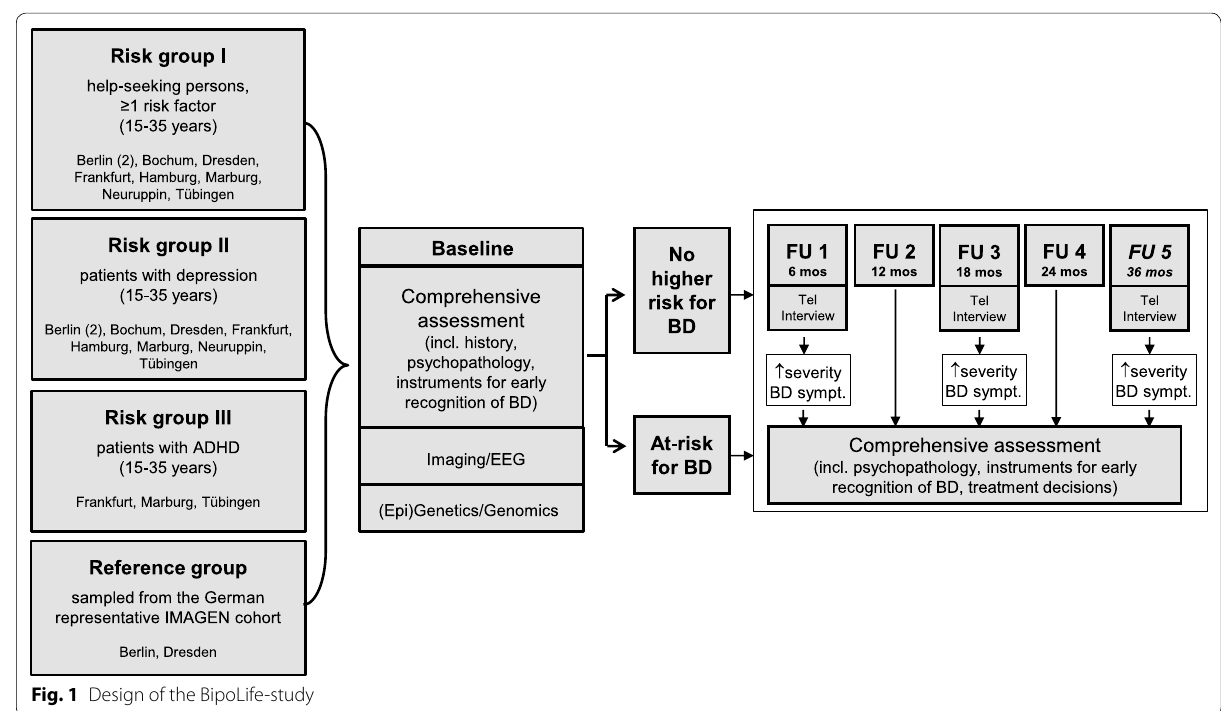
Fig. 1 Design of the BipoLife‑study